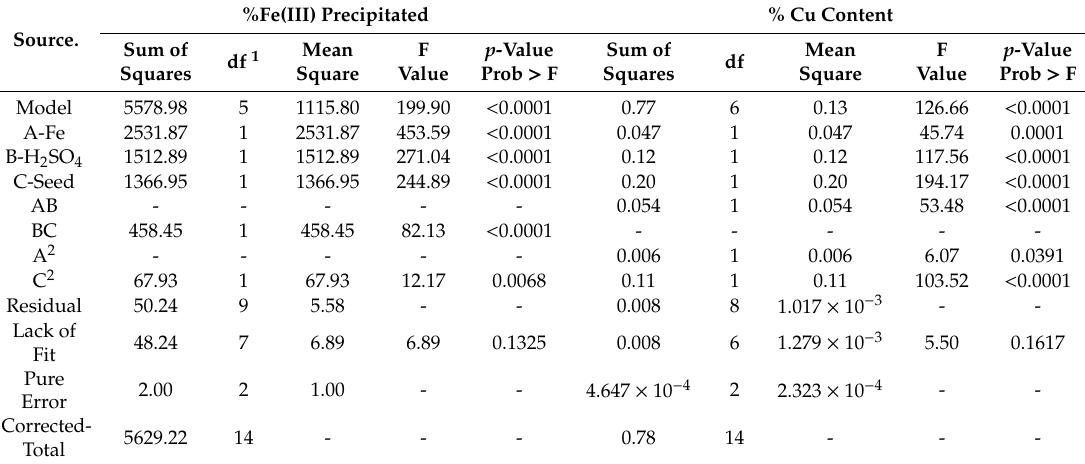
Table 7. Analysis of variance for the fitted quadratic